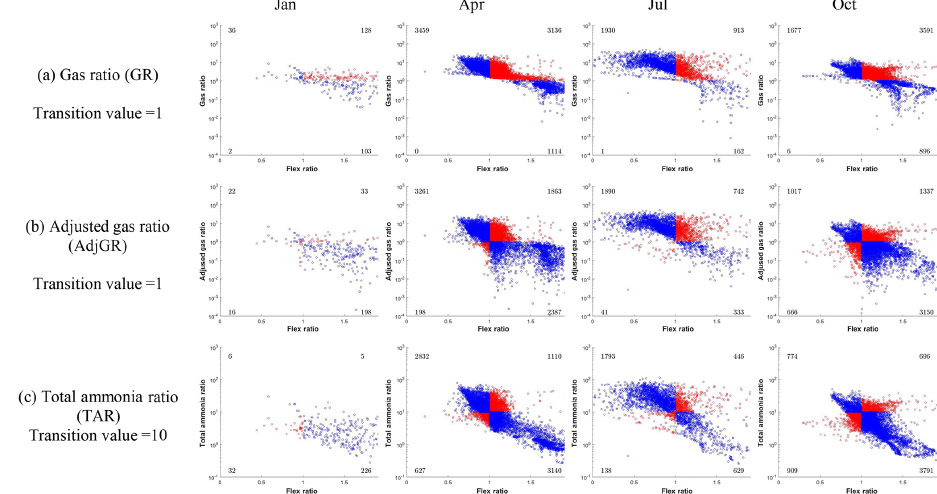
Figure 5. Performance of observable indicators in predicting PM 2 . 5 chemistry. The x axis represents the FR values where the transition value is 1, and the y axis represents the observable indicators. The blue dots represent the grids where PM 2 . 5 chemistry is successfully predicted by the observable indicator; the red dots represent the grids where the observable indicator fails to predict PM 2 . 5 chemistry. The numbers in the four corners represent the grid number in each section; the number in January is much lower than those in the other months because most grids are located in the NH 3 -poor conditions with FR > 2 in January.